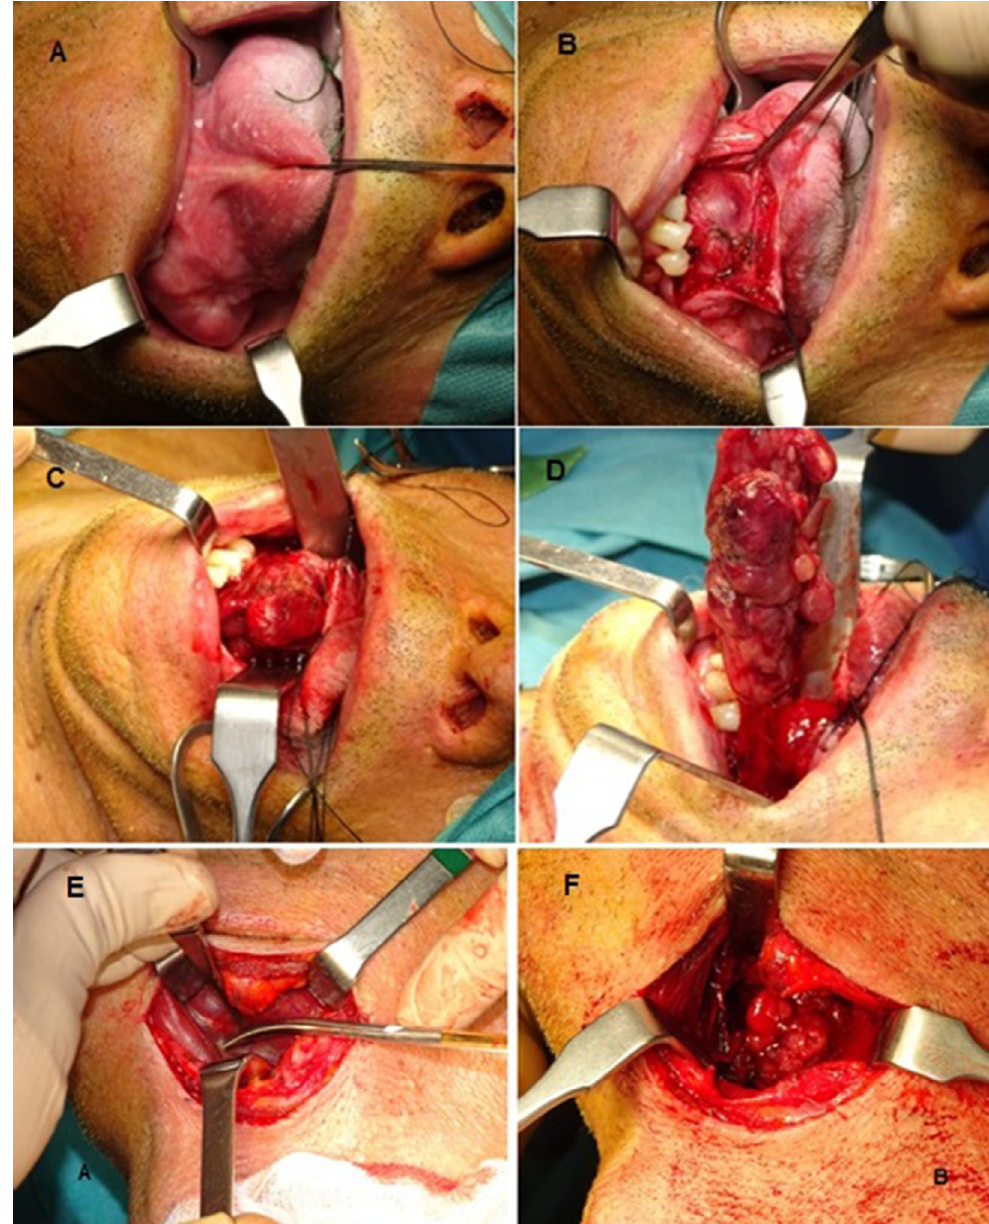
Fig. 1. (A) left tongue base swelling with intact mucosal covering; (B) intraoral approach for mass excision; (C) dissection around capsule of mass; (D) complete excision of huge tongue mass; (E) transcervical approach; (F) dissection till tongue base to expose the mass to facilitate its